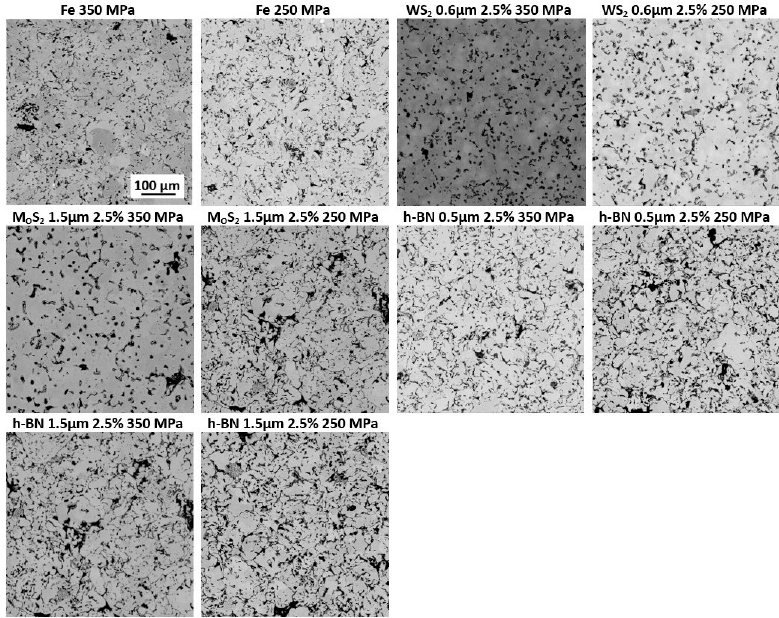
Figure 8. Scanning electron micrograph showing microstructures of obtained samples (magnification Figure8. Scanningelectronmicrographshowingmicrostructuresofobtainedsamples(magnification500 × ). 500×).